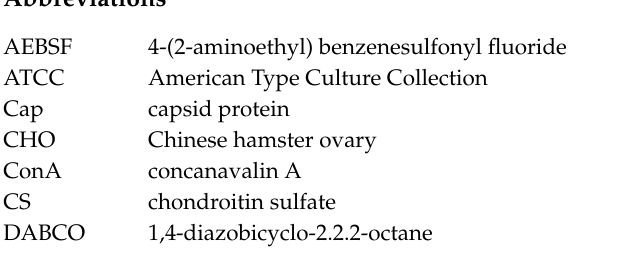
Figure S1: E ff ect of a combination of amiloride and chlorpromazine on PCV2 entry / infection of